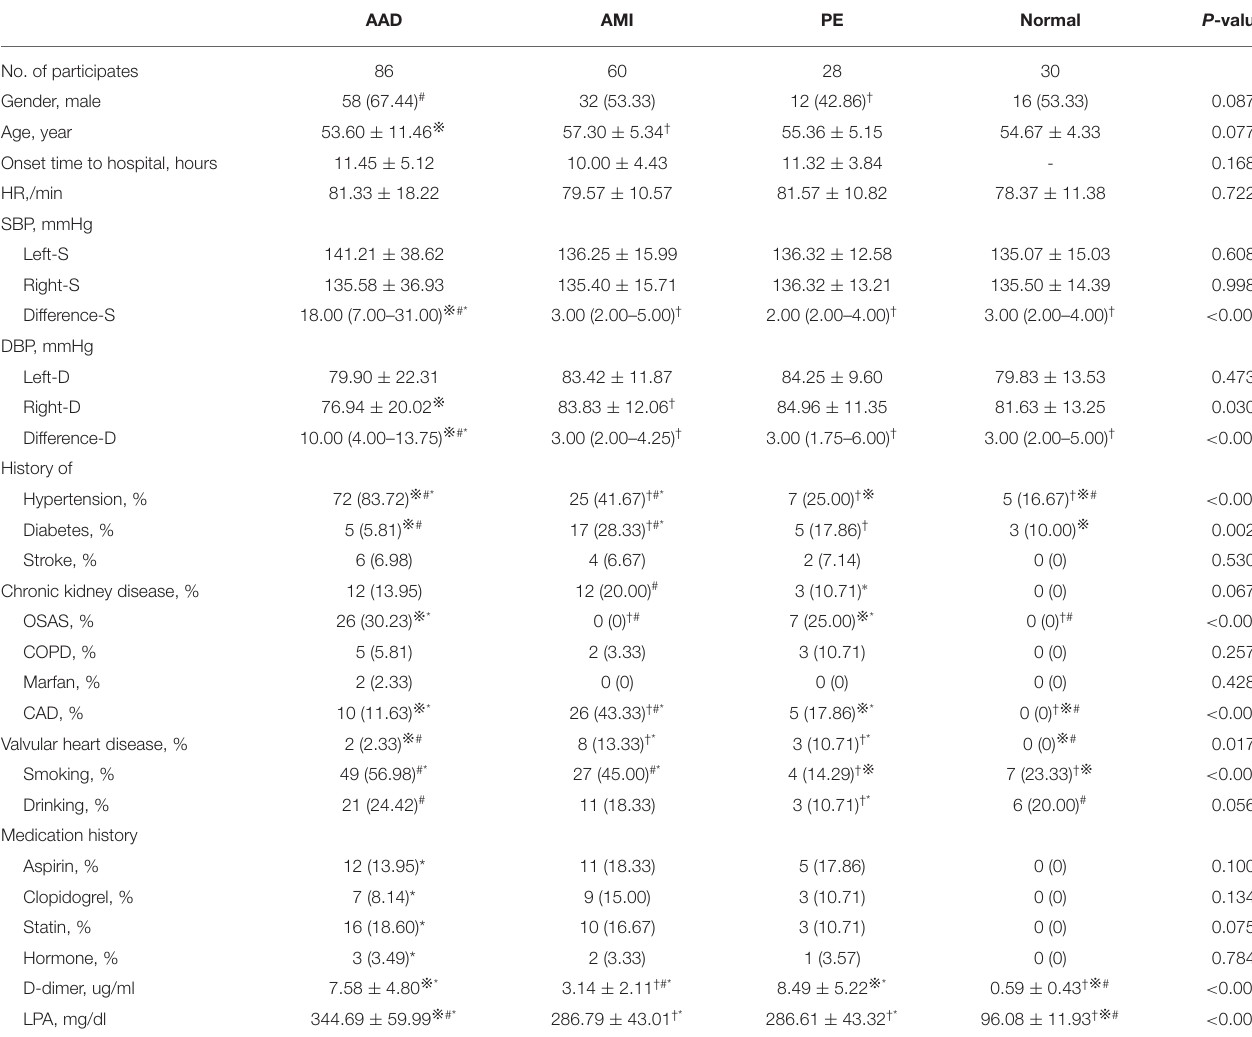
TABLE 1 | Baseline characteristics of chest pain patients with AAD vs. other